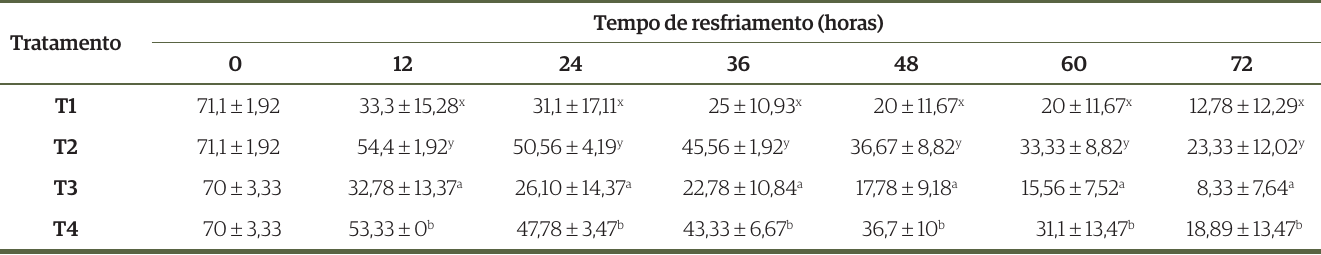
Tabela 1. Médias ± desvios padrões referentes à motilidade do sêmen submetido à refrigeração, avaliado durante o periodo de 72 horas, com acréscimo